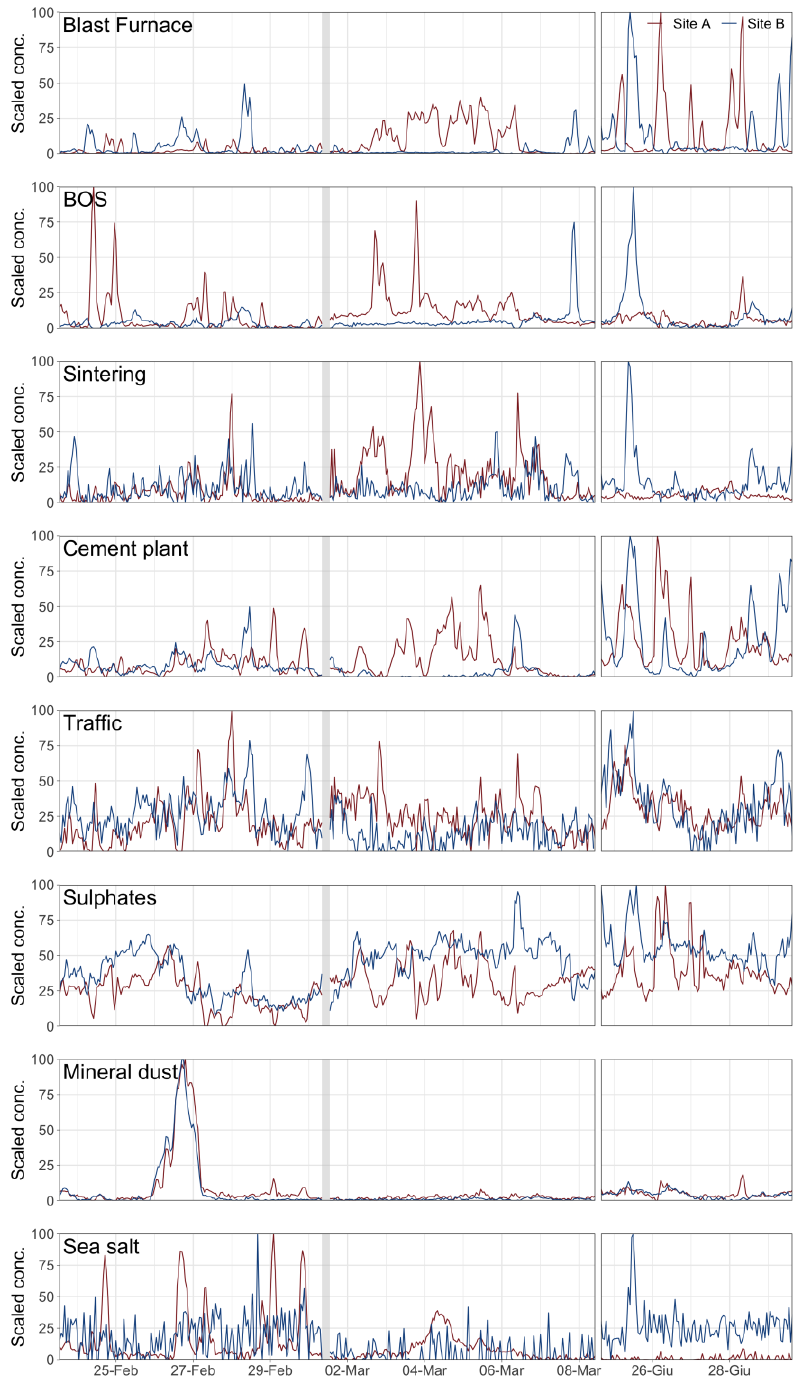
Figure 8. The temporal patterns of the identified factors in the fine fraction (in arbitrary units) in both the sampling sites.